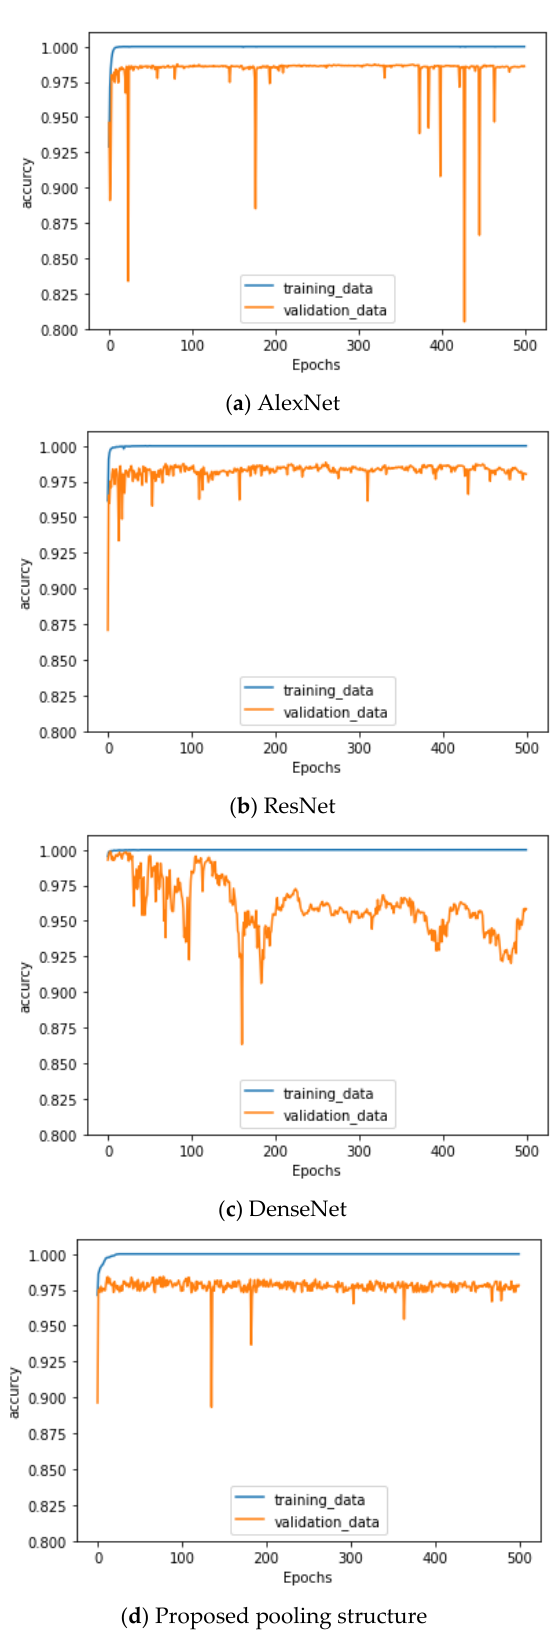
Figure 11. Performance Comparison of Neural Network Models using Caltech 101 Data.